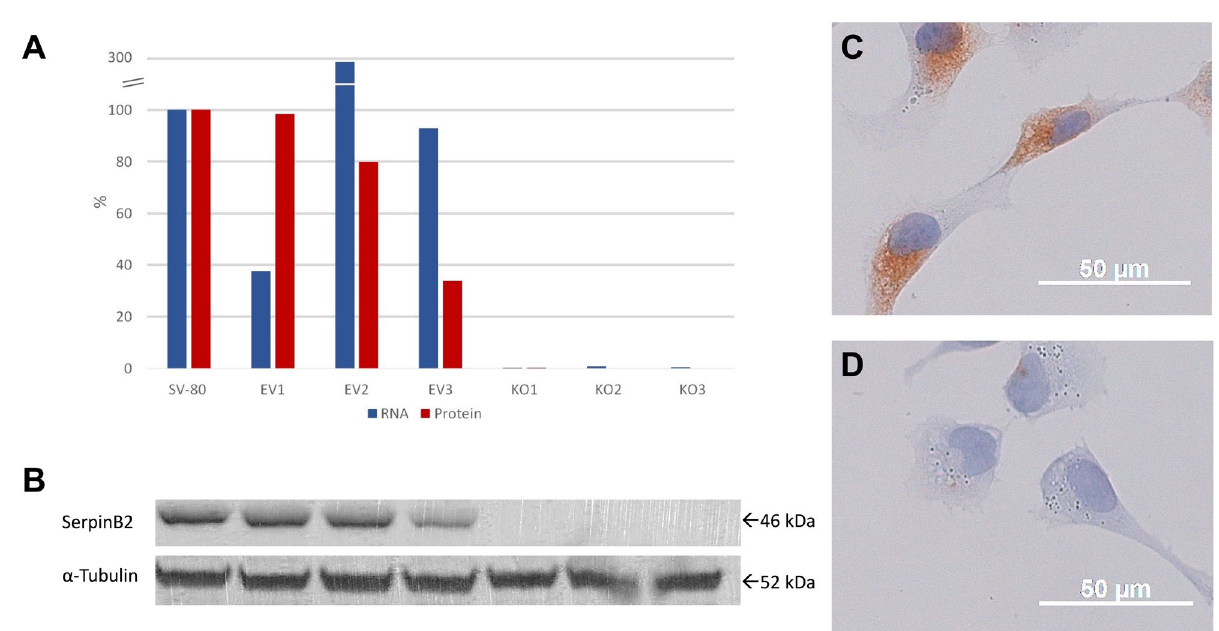
Figure 3. Knock out of SERPINB2 in fibroblasts: qPCRs demonstrating SERPINB2 mRNA levels at or below the level of detection in the analyzed clones KO1-3, but not in the control clones EV1-3 ( A ). Western blot analysis revealed knock-out on the protein level for KO1-3 as well ( B ). Densitometry analysis is shown in A. Immunocytochemistry for SERPINB2 demonstrating strong staining in the control clones ( C ) and reduced to absent staining in knock-out clones ( D